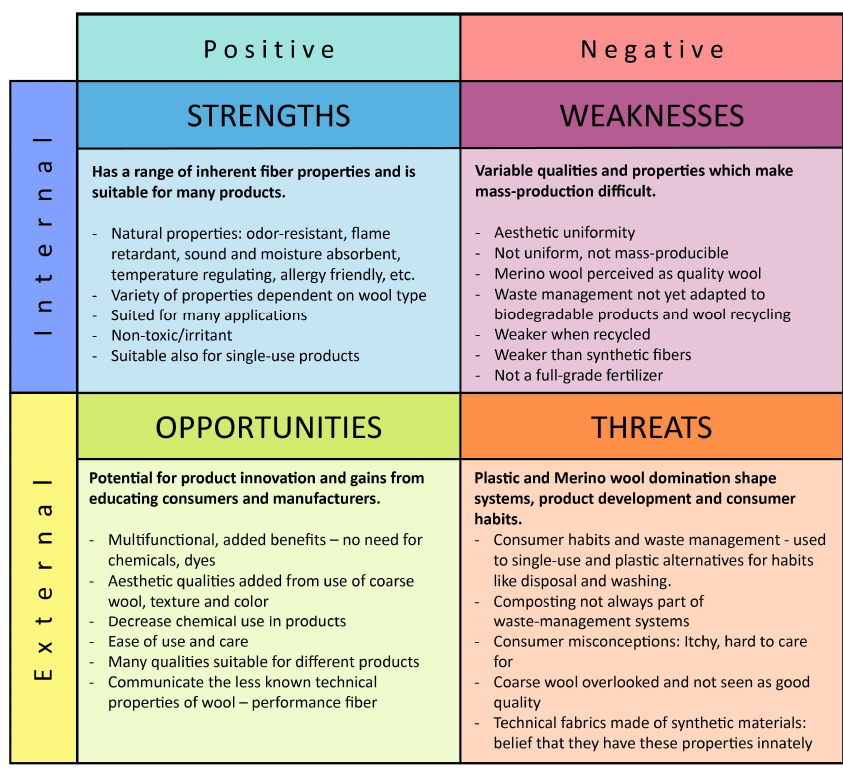
Figure 3. SWOT—Properties and product performance.